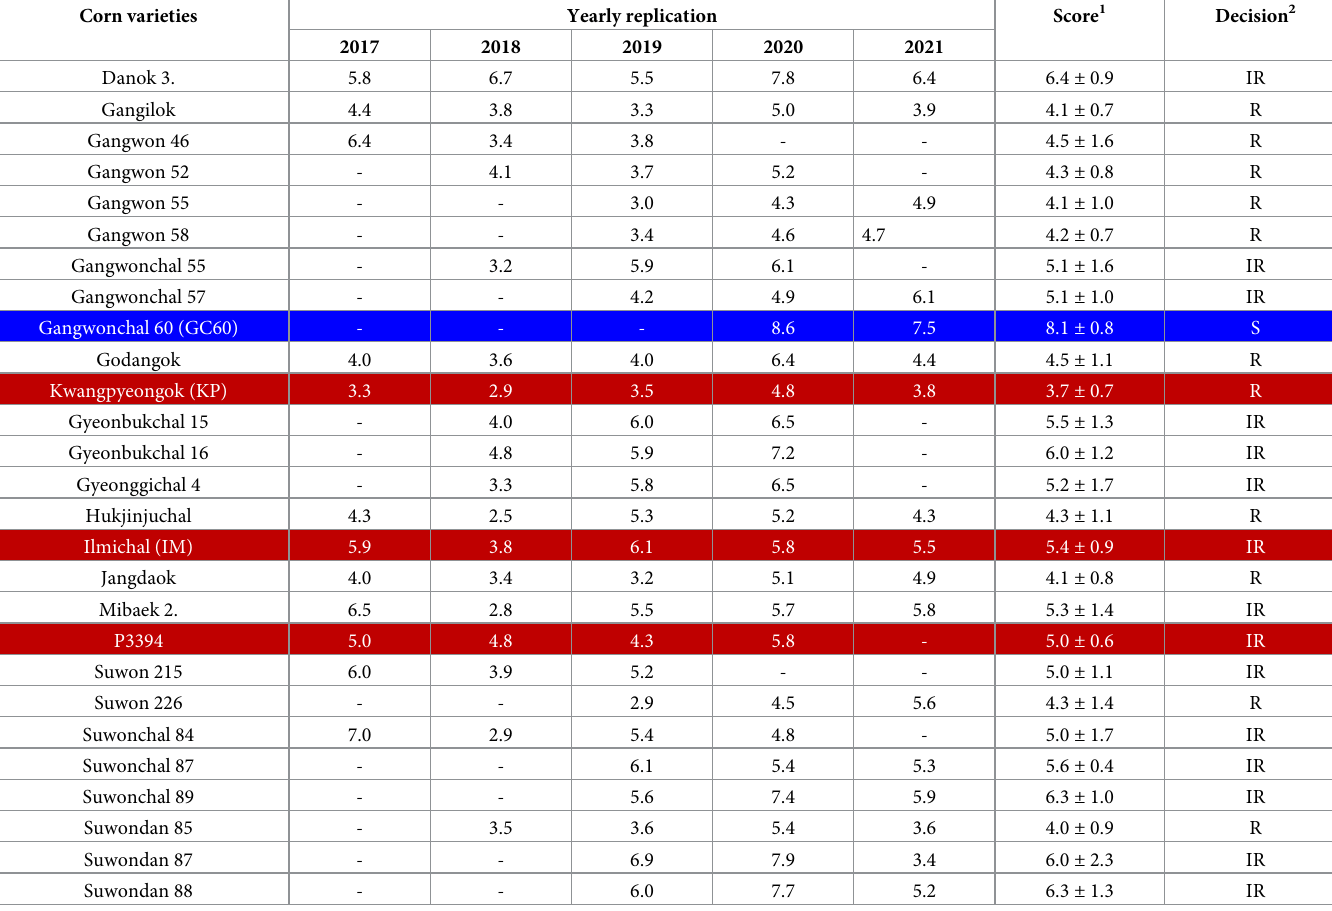
Table 1. Screening 27 corn varieties against infestation by O . furnacalis . Corn